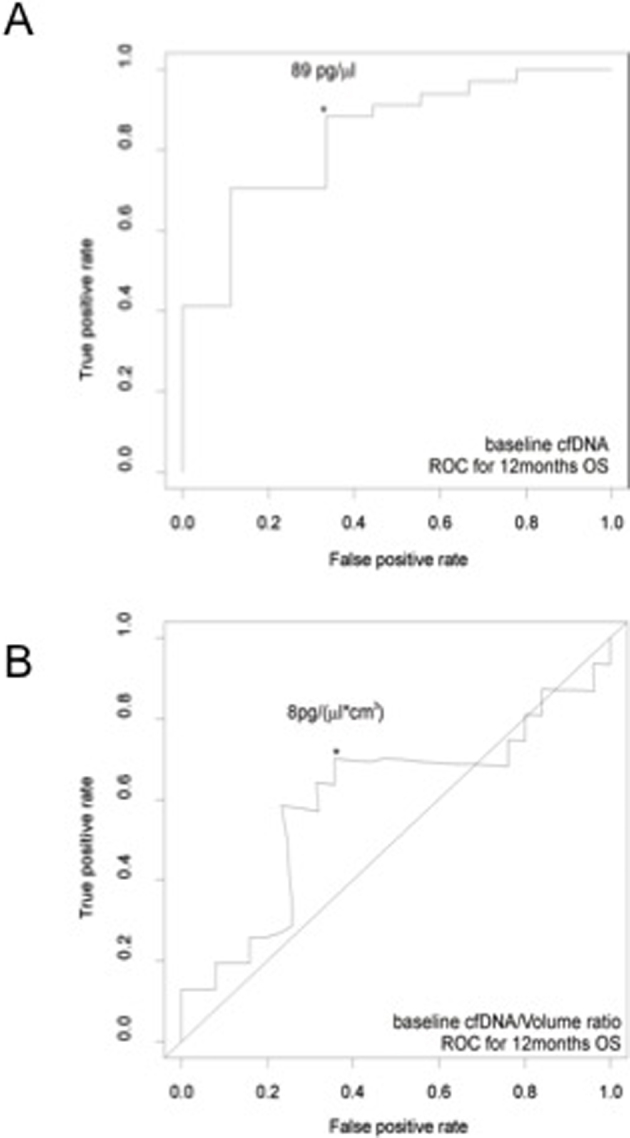
Validation of the linear regression multivariate analysis of baseline cfDNA, tumour burden, renal clearance and while cell count values. Validation plots for the multivariate linear regression model used to analyse the relationship of baseline cfDNA, tumour burden, glomerular filtration rate and while cell count values.